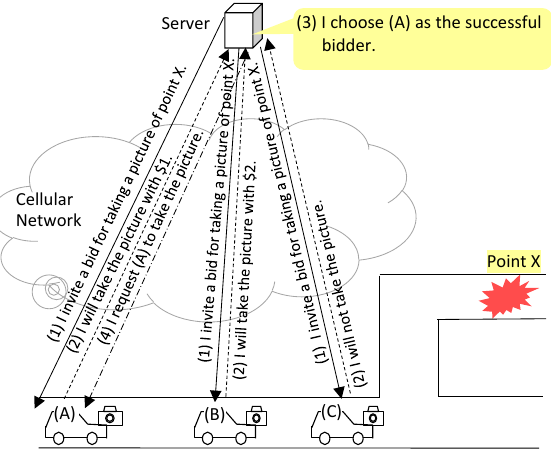
Figure 1. Example of MCS using RevAuc.